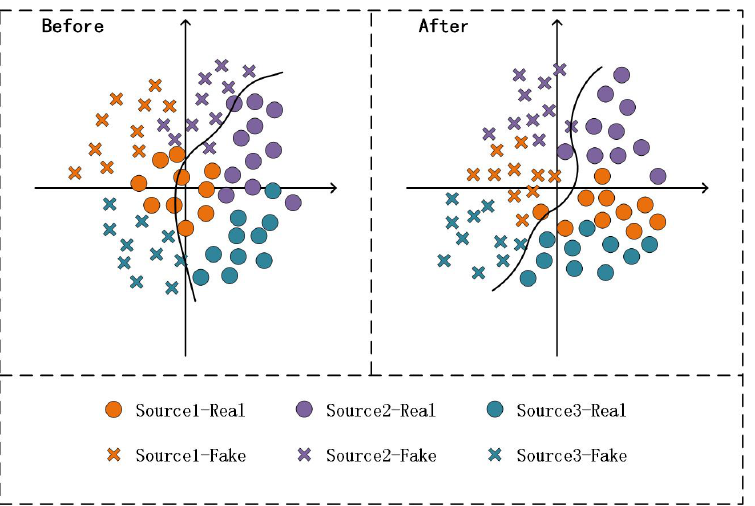
Figure 1. Schematic diagram of the multi-source domain alignment algorithm proposed in this method. The distribution plot on the left illustrates the sample distribution from the source domain before feature alignment, while the plot on the right demonstrates the distribution after feature alignment in the feature space. Notably, the original distributions from different domains exhibit distinct dissimilarities; however, the feature alignment enhances the uniformity of each domain’s distribution in the feature